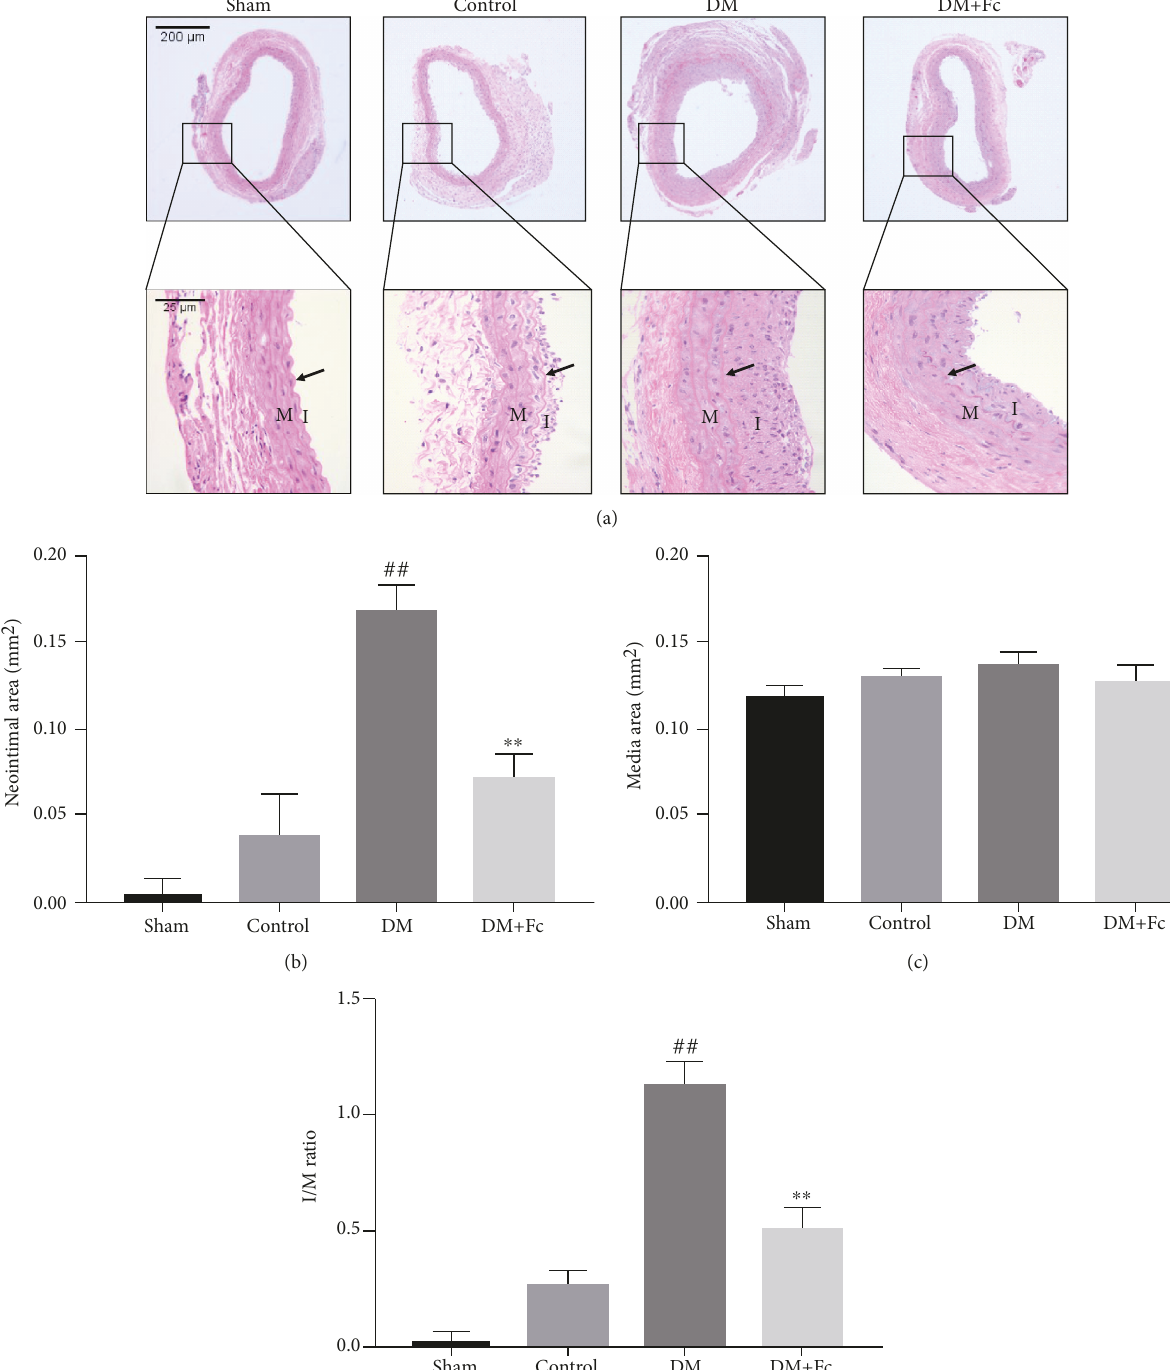
Figure 3: E ff ects of notoginsenoside Fc (Fc) on pathomorphology and intimal hyperplasia following carotid artery injury. (a) Representative photographs of carotid arteries by hematoxylin-eosin staining at 14 days are shown. Images are at 50x magni fi cation and 400x magni fi cation. Scale bars = 200 μ m and 25 μ m. Black arrows indicate elastic lamellae. I refers to intima and M refers to media. (b) Neointimal area of carotid arteries within each treatment group. (c) Media area of carotid arteries within each treatment group. (d) Neointima-to-media area ratios of carotid arteries within each treatment group. Data are shown as the mean ± standard deviation. ## P < 0 01 vs. the control group; ∗∗ P < 0 01 vs. the diabetes mellitus (DM) group. n = 6